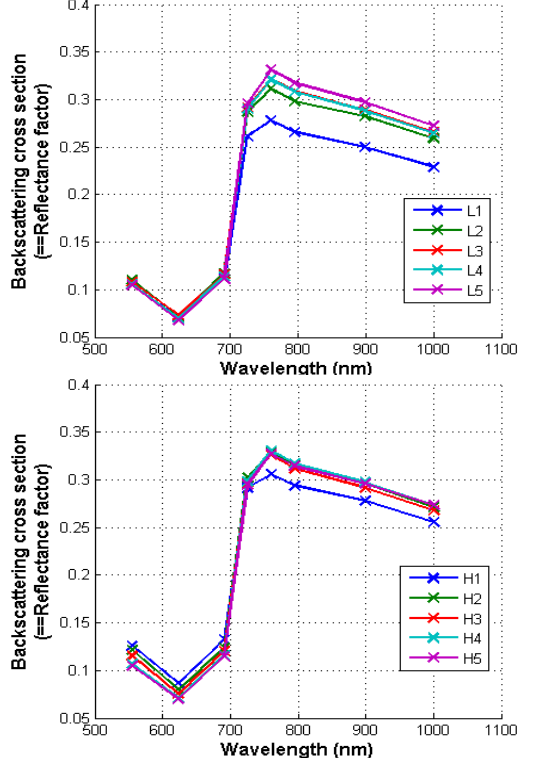
Figure 1 Average reflectance spectra of the side scanned oat samples. L indicating low and H high seeding density and the numbers from one to five indicate fertilization level with five being the highest fertilization level.